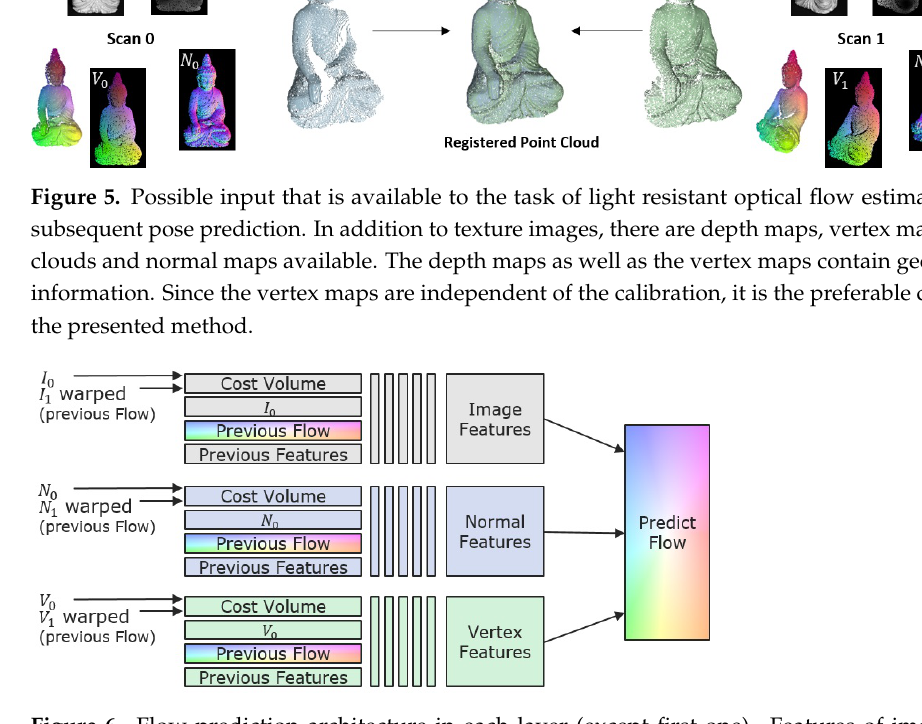
Figure 6. Flow prediction architecture in each layer (except first one). Features of images (tex- ture), normals (shading) and vertices (geometry) are extracted separately and jointly fed to the prediction